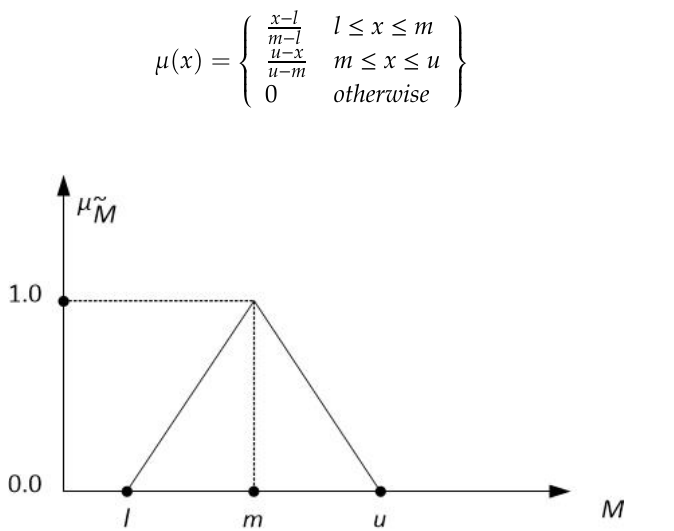
Figure 2. The presentation of a triangular fuzzy number.